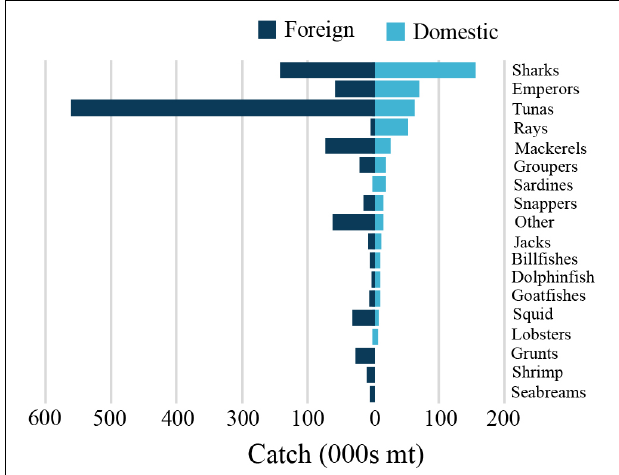
FIGURE 6 | Overlap of catch composition for foreign and domestic fleets fishing in Somali waters. Total catch per species group calculated from catch estimates during